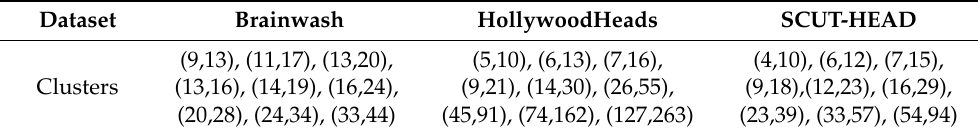
Table 3. The corresponding clusters on the Brainwash, Hollywoodheads, and SCUT-HEAD